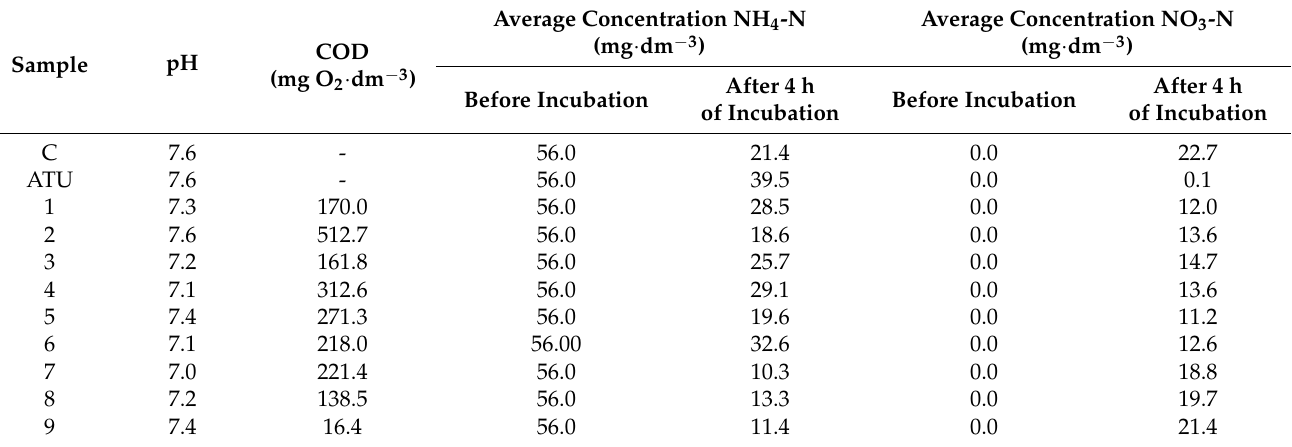
Table 4. Impact of the filtration process on the degree of nitrification inhibition in activated sludge.